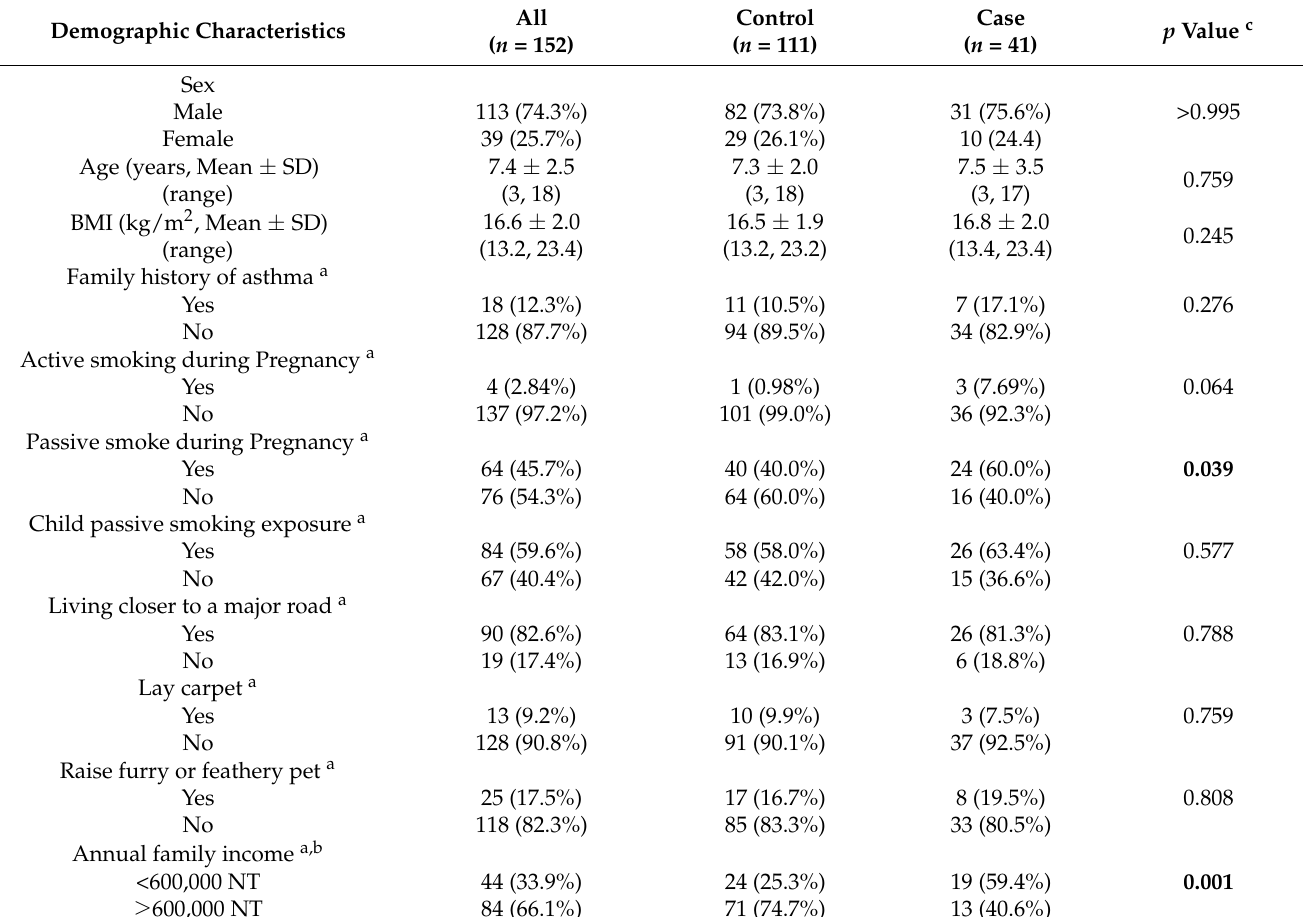
Table 1. Comparison of the demographic characteristics between the case and control